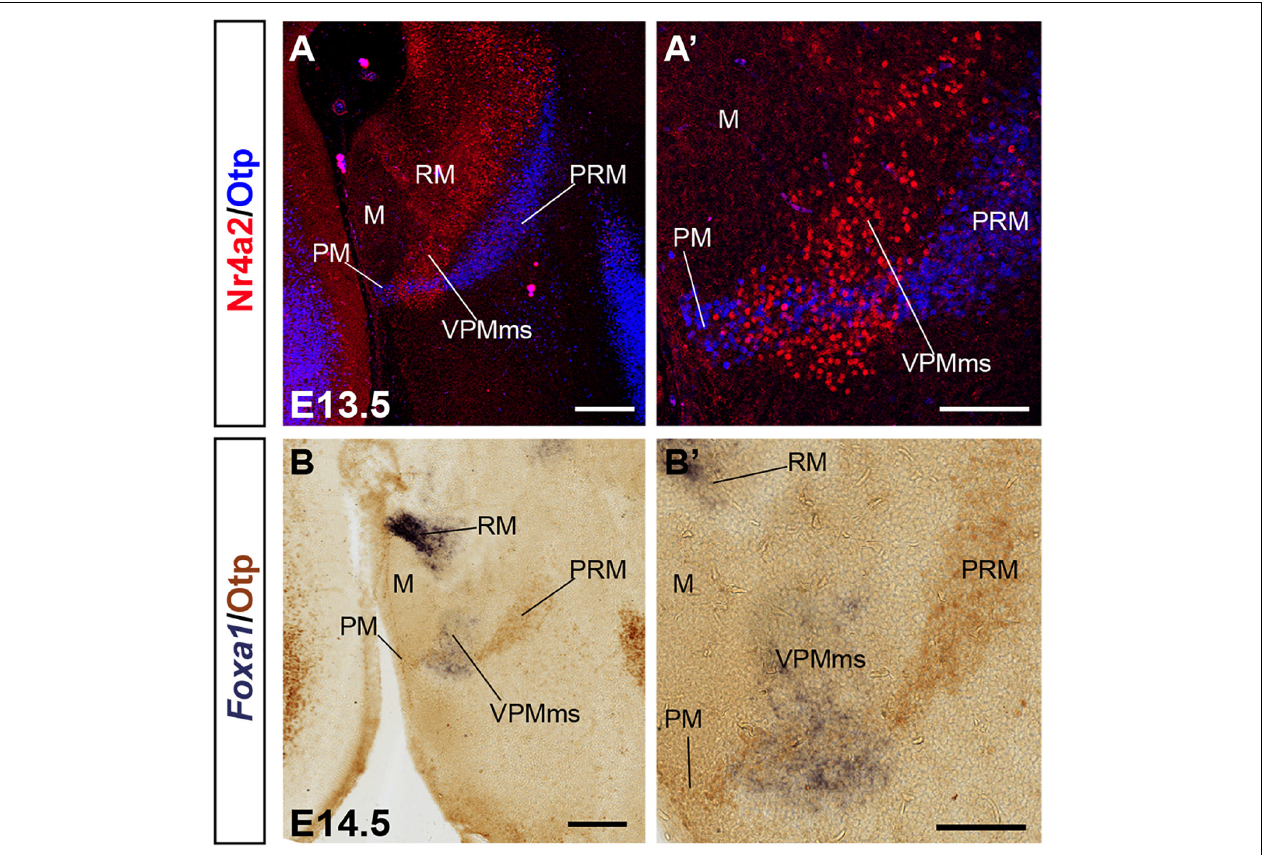
FIGURE 4 | VPMms crosses obliquely the PRM-PM band at E13.5. (A,A’) Sagittal section at E13.5 and higher magnification detail showing double immunofluorescence for Nr4a2 (red) and Otp (blue) illustrating Nr4a2-positive VPMms bridge cells across the PM band. (B,B’) Sagittal section at E14.5 and higher magnification detail illustrating Foxa1 in situ hybridization and immunohistochemistry for Otp. Migrated Foxa1 -positive cells of the VPMms bridge lie across the PM band. Scale bars in (A,B) represent 200 µ m. Scale bars in (A’,B’) represent 100 µ